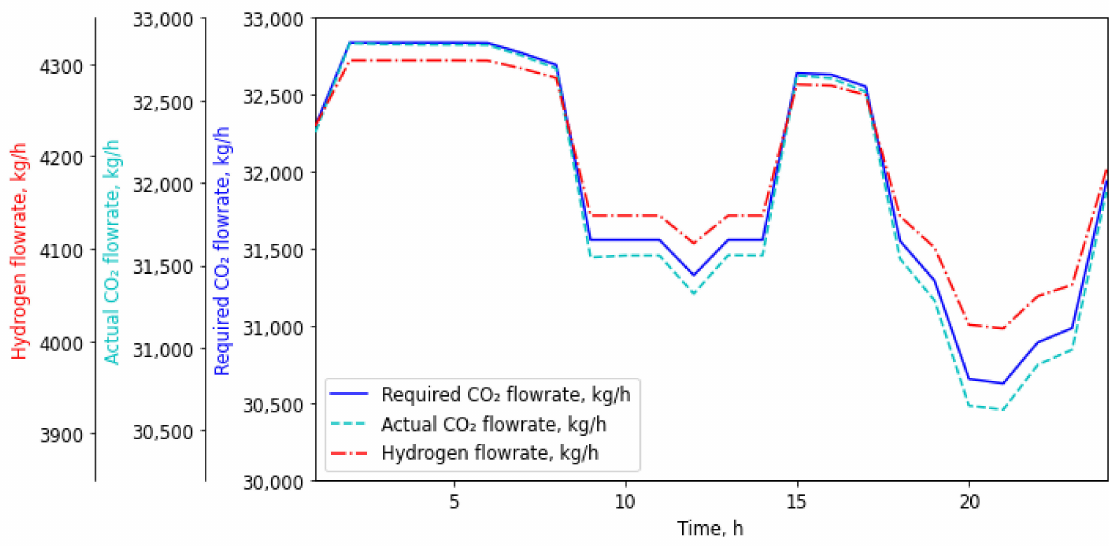
Figure 12. 20-MW wind energy, Heide (Germany) 2019. Generated from the model by Pfenniger and Staffell [49].